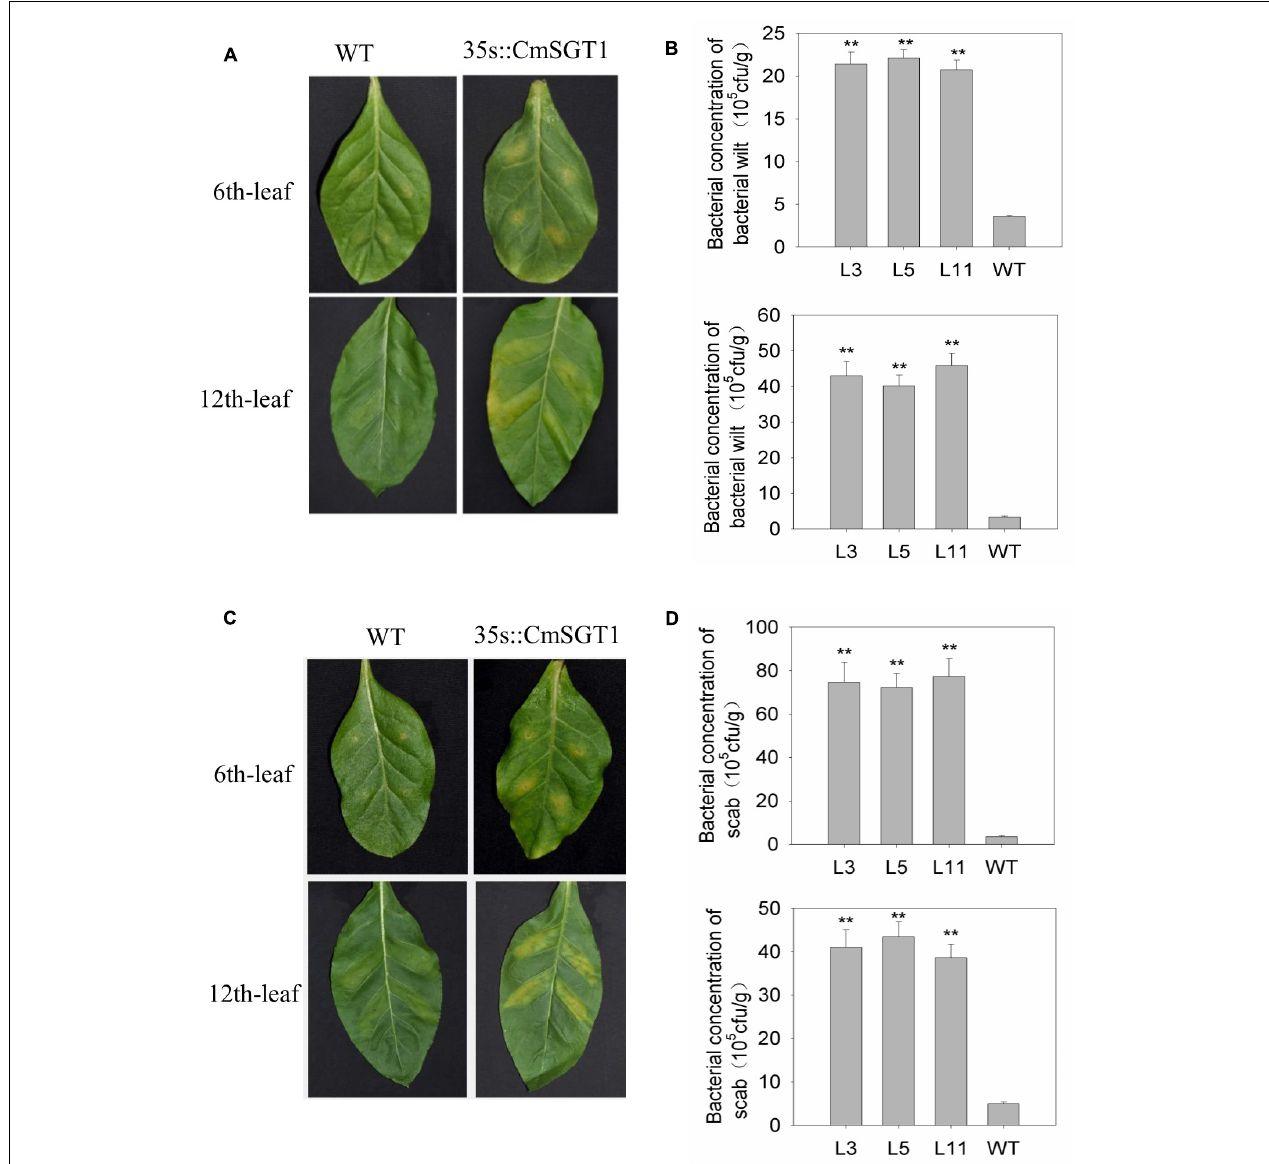
FIGURE 6 | The resistance of CmSGT1 in transgenic and wild-type plants to N. benthamiana bacterial wilt and scab. (A) pathogens symptoms of the 6th-upper and 12th-upper leaf injection sites was injected with bacterial wilt bacteria with a needle-removed syringe. (B) concentration bacteria of the 6th-upper and 12th-upper leaf injection sites was injected with bacterial wilt bacteria with a needle-removed syringe. (C) pathogens symptoms of the 6th-upper and 12th-upper leaf injection sites was injected with scab bacteria with a needle-removed syringe. (D) concentration bacteria of the 6th-upper and 12th-upper leaf injection sites was injected with scab bacteria with a needle-removed syringe. “ ∗∗ ” denotes significant differences between WT and transgenic plants at p <